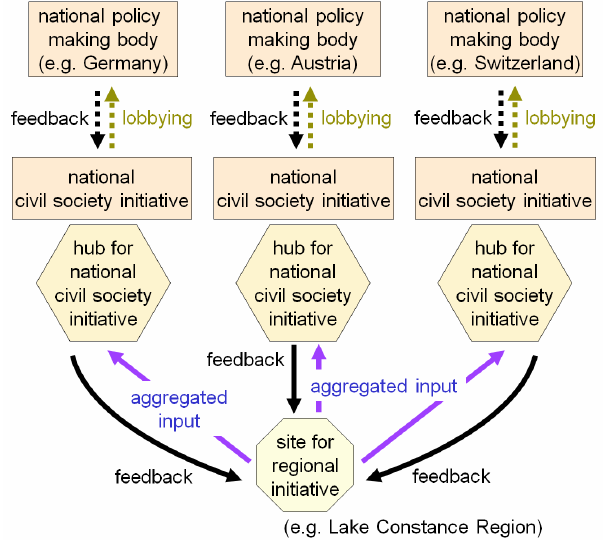
Figure 3: Example of interaction between sites and hubs